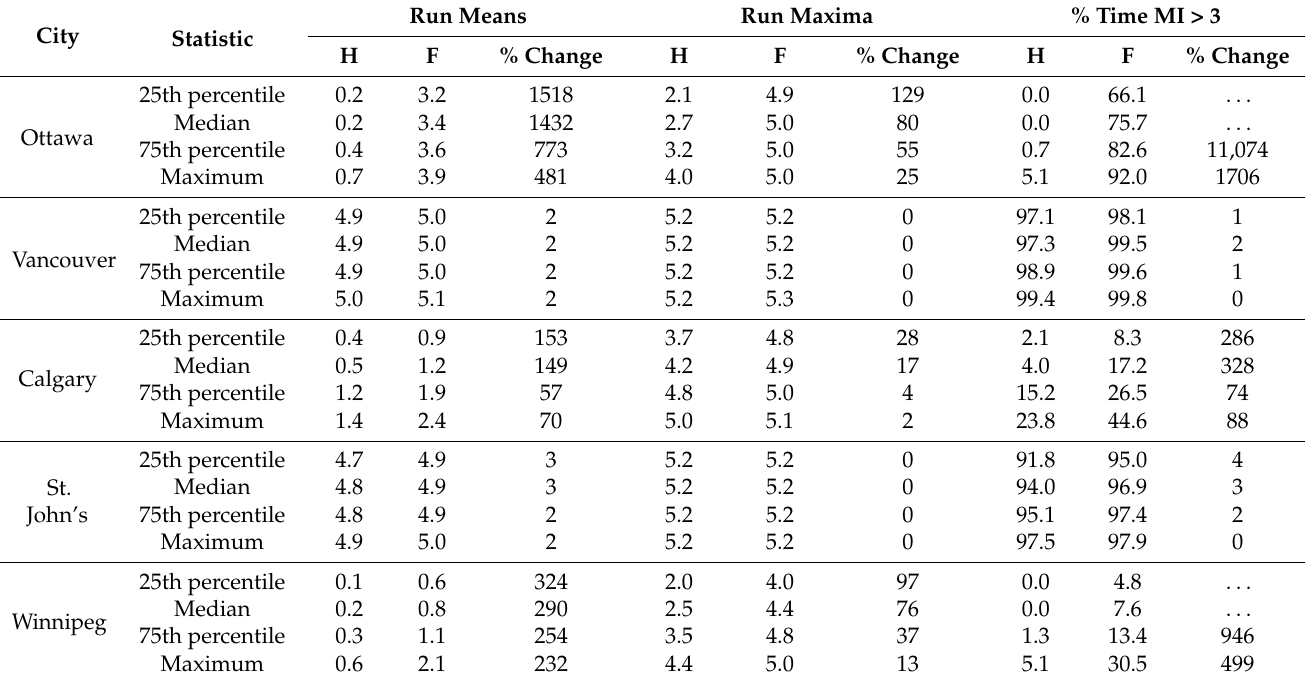
Table 3. Projected changes in mold index statistics under a global warming scenario of 3.5 ◦ C (F: 2062–2092) in com-parison with the reference period (H: